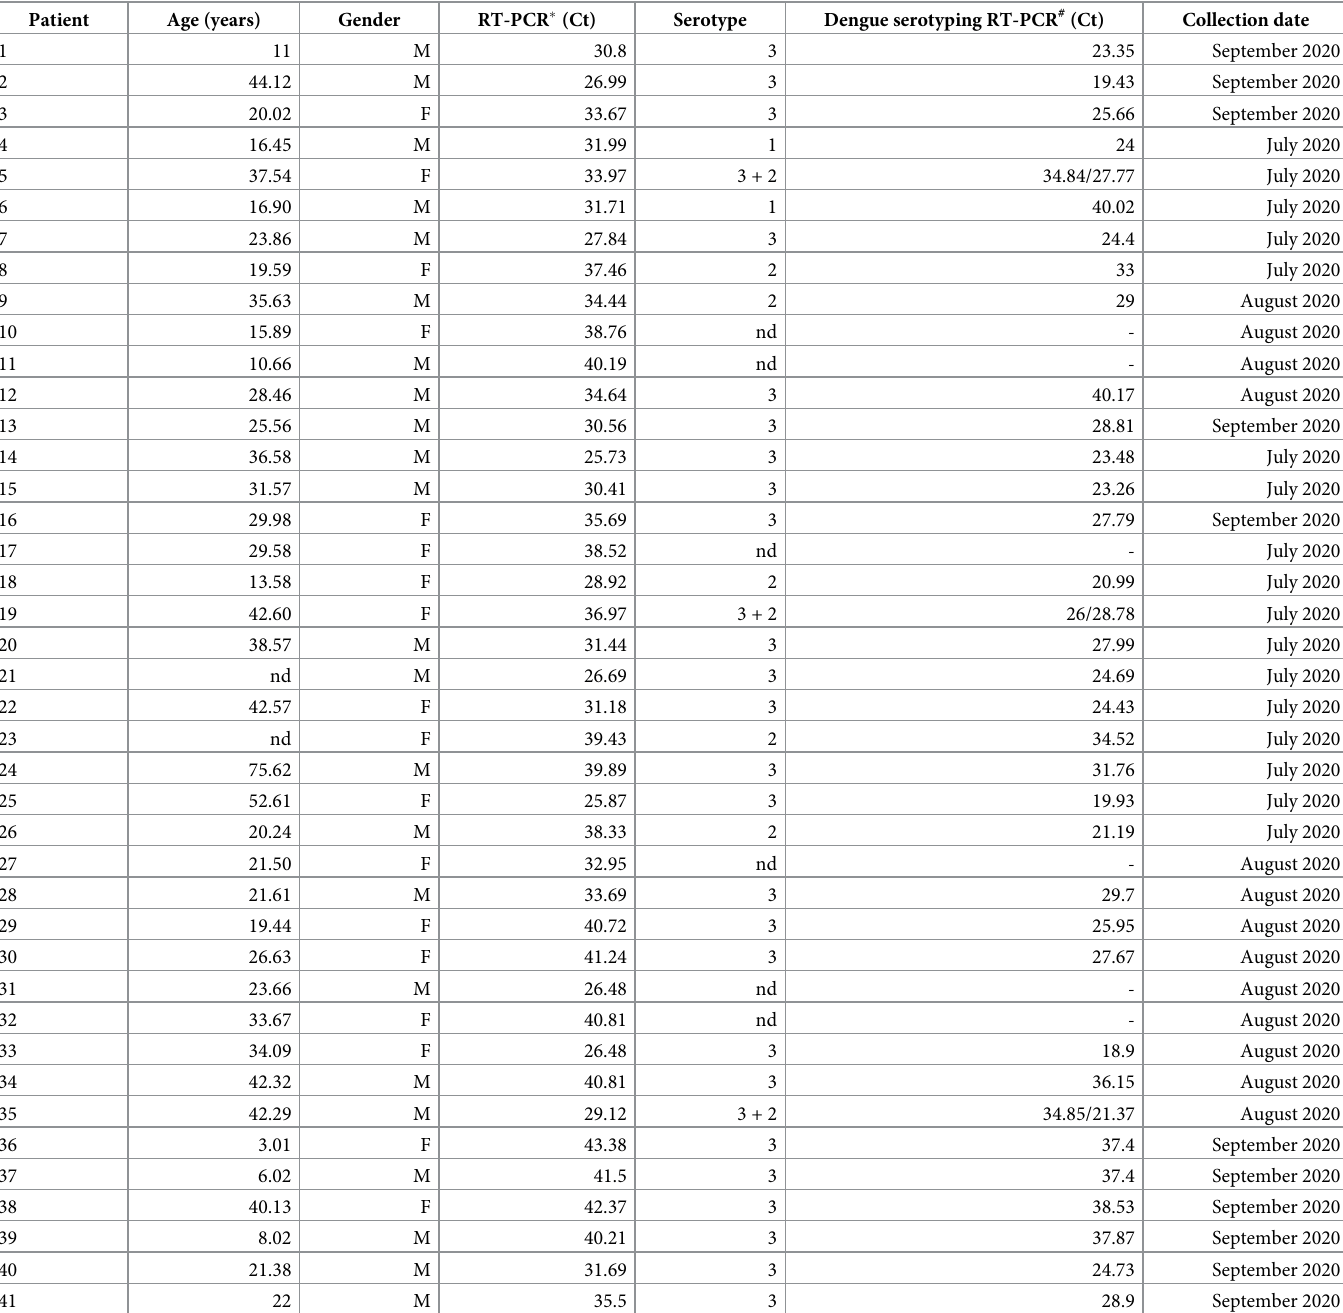
Table 3. Description of the dengue positive cases found from July to September 2020 in Douala.